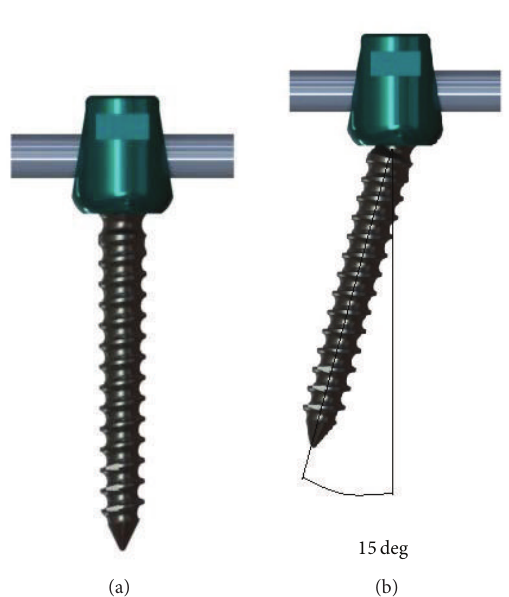
Figure 1: (a) Vertically fixed and (b) fixed with angle.